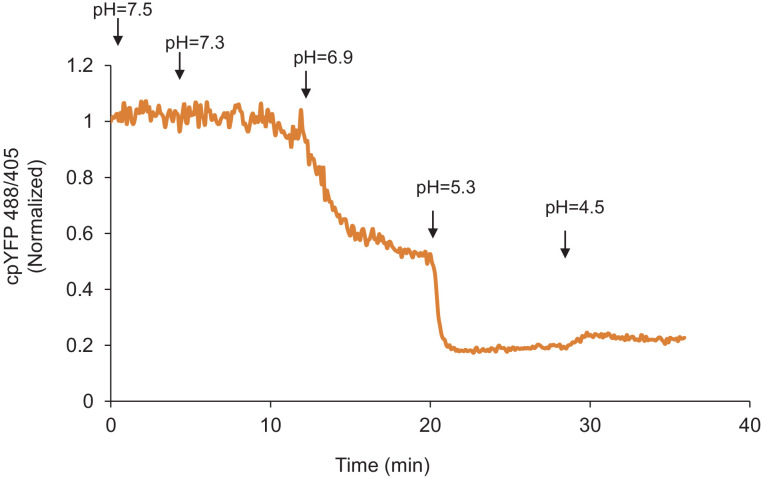
Mitochondrial proton entry in buffer without phosphate.Mitochondrial pH stress on permeabilized rat cardiomyocytes in a buffer that did not contain phosphate.